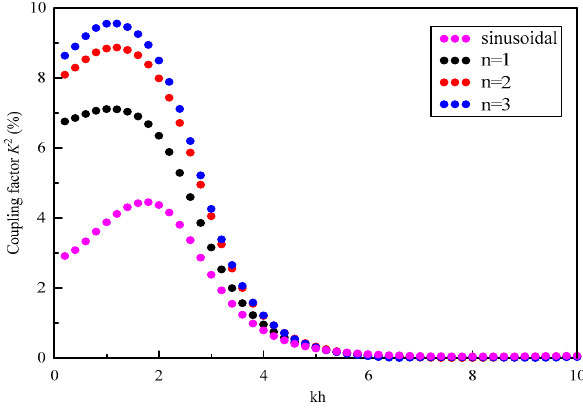
Figure 10. Effect of graded field on magneto-electromechanical coupling factor for S0 mode.